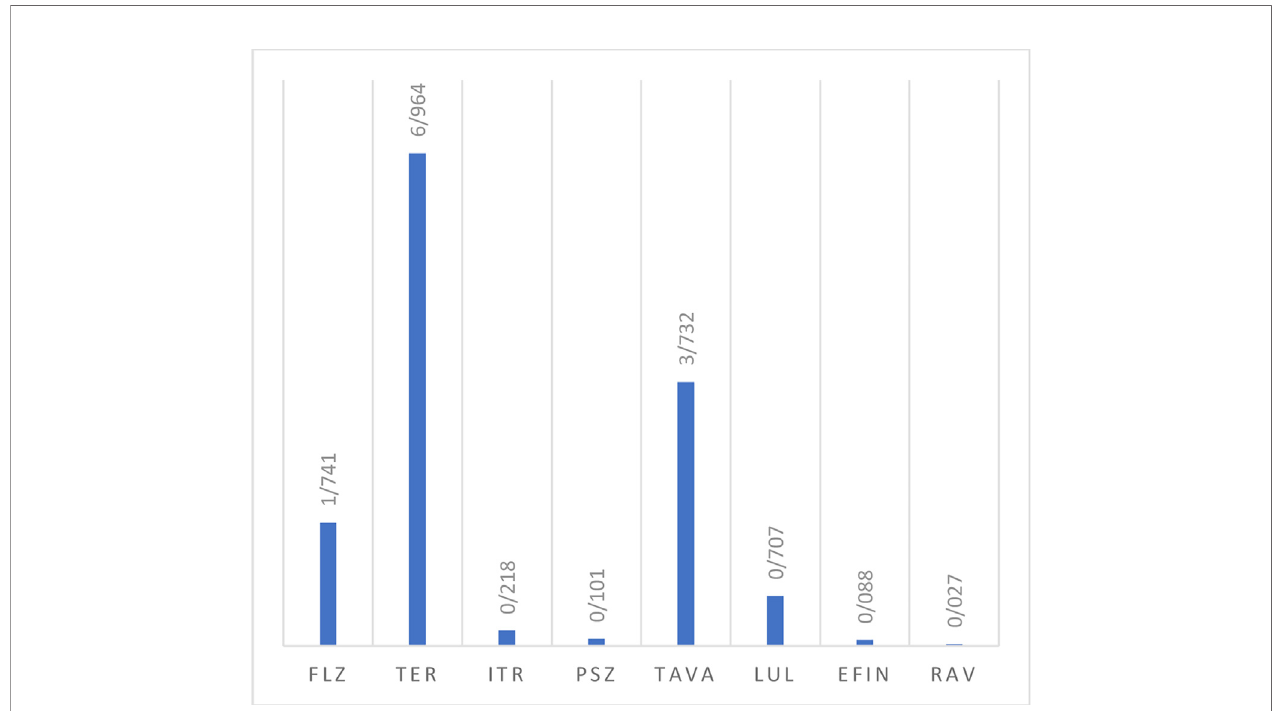
FIGURE 2 | The geometric mean obtained by testing the susceptibility of yeast isolates to each antifungal agent.